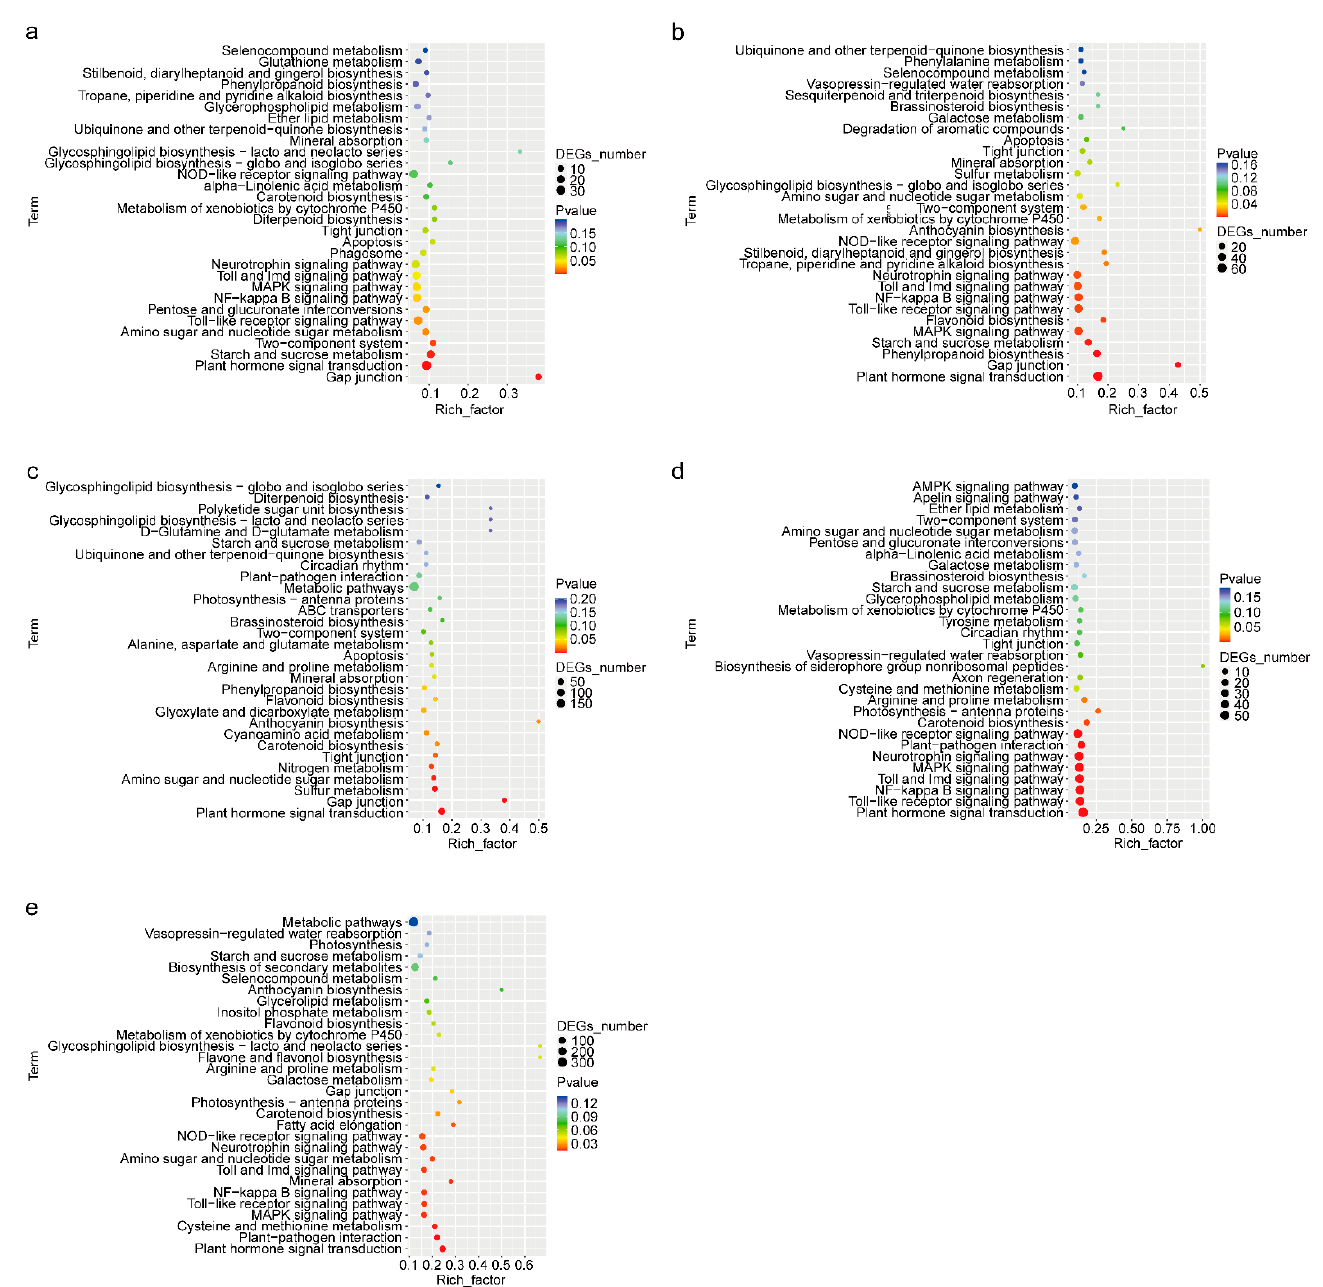
Figure 4. KEGG enrichment map of cold-induced DEGs. ( a ) 3 h vs. CK (0 h); ( b ) 6 h vs. CK; ( c ) 9 h vs. CK; ( d ) 12 h vs. CK; ( e ) 24 h vs. CK. The horizontal axis represents the enrichment factor, that is, the ratio of the number of differential genes enriched to a certain KEGG pathway to the number of background genes obtained by sequencing; the vertical axis represents the enriched function of the KEGG pathway: the larger the circle, the more enriched. The number of differential genes for this function is relatively more. The color spectrum from blue to red represents uncorrected p -values.